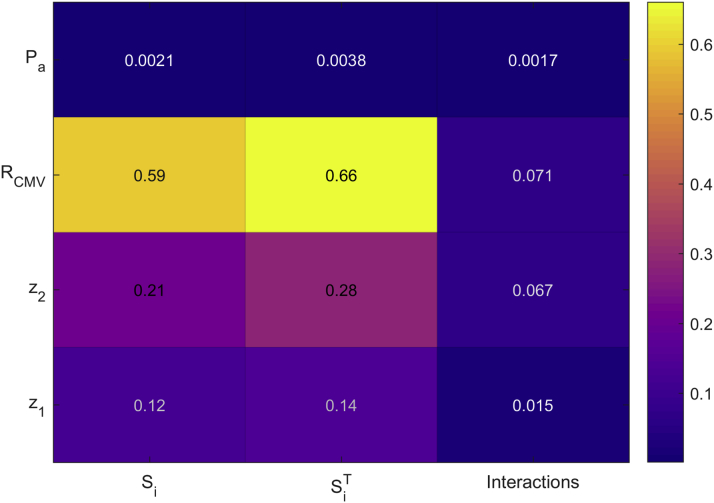
Sensitivity Index HeatmapThe main sensitivity indices (Si), total sensitivity indices (SiT), and interaction effects are displayed for the 4 input parameters: RCMV, geometry parameters (z1 and z2), and average proximal pressure (Pa). The axis on the right indicates the magnitude of the influence on output (vFFR) result, with higher values having a stronger influence on result. CMV resistance is the dominant influence on vFFR result. CMV = coronary microvascular; RCMV = CMV resistance; other abbreviations as in Figure 3.